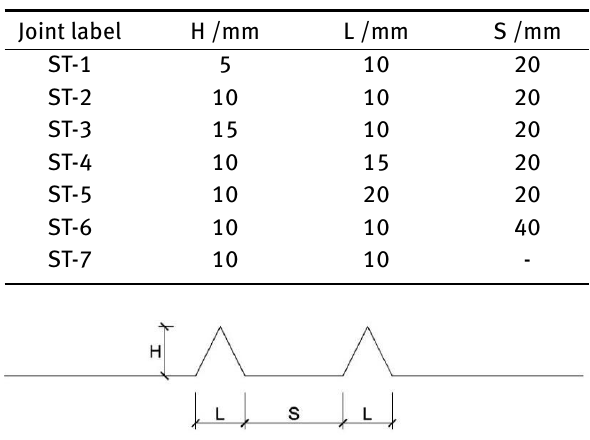
Table 3: Morphology parameters of joint specimens